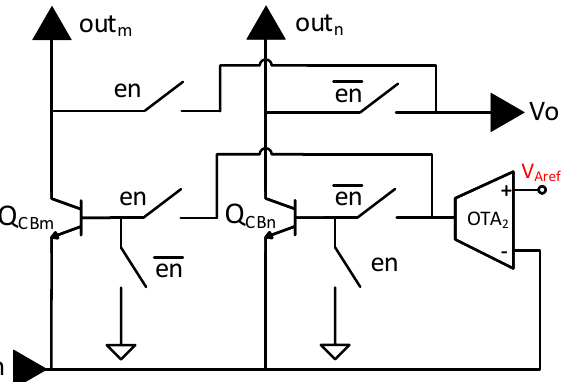
Figure 4. Implementation of the summing current switch. out m is used for the high gain output and out n for the low